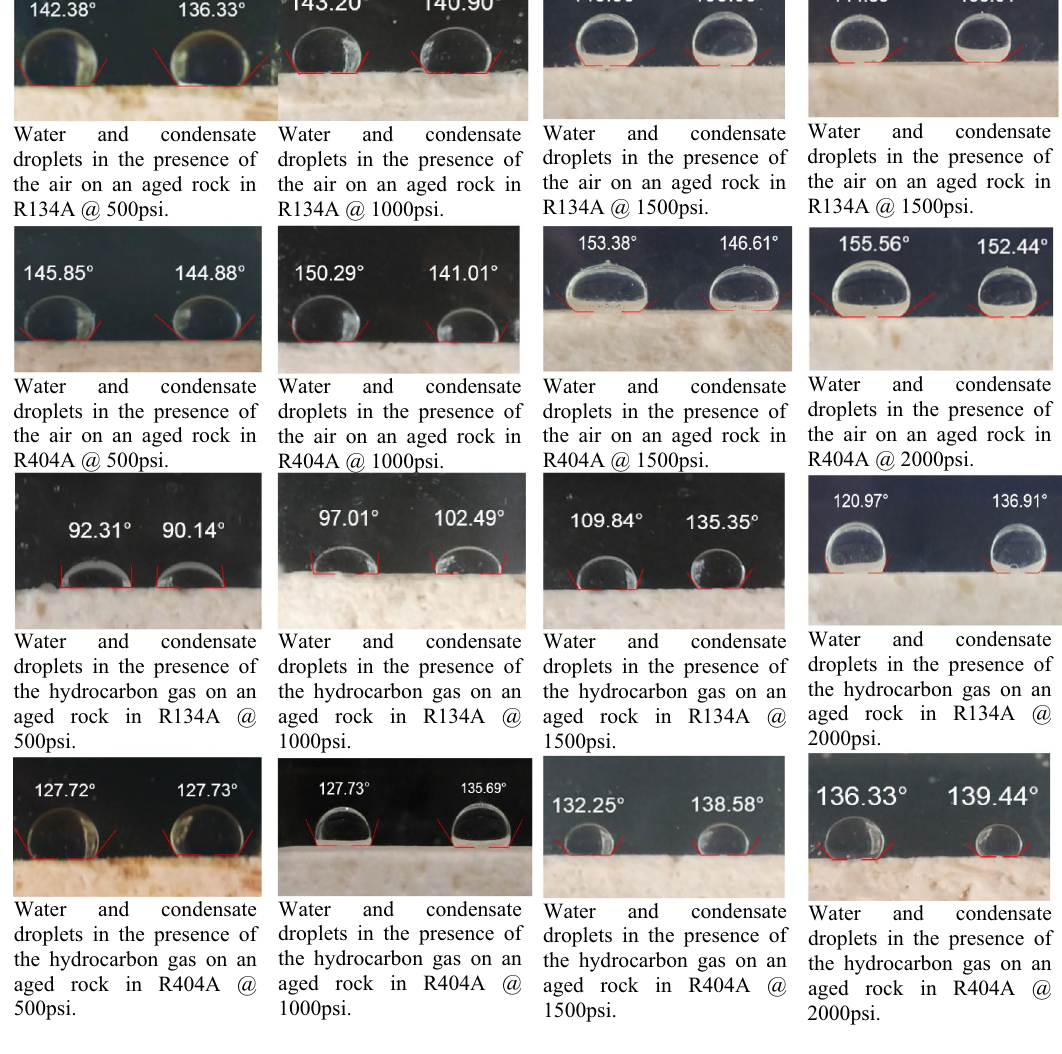
and a duration of 72 h (the left drops are water and the right are gas